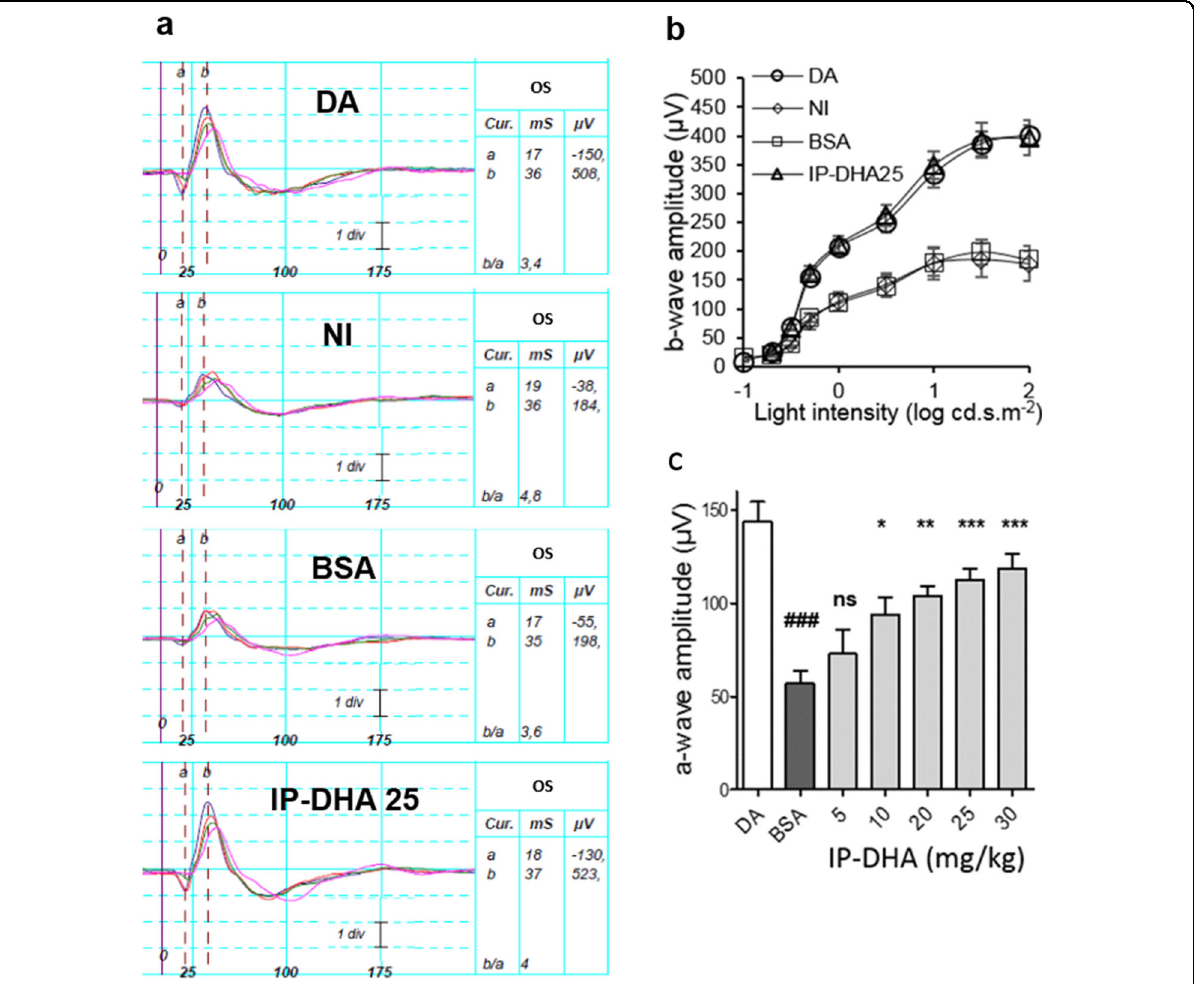
Fig. 4 Full- fi eld ERG recordings after light-induced acute retinal degeneration. a Full- fi eld ERG responses of IP-DHA (25 mg/kg)-treated or BSA- treated Abca4 − / − mice following light exposure were recorded under scotopic conditions and compared to nonexposed (DA) and noninjected (NI) light-exposed littermates. Data are representative ERG responses from left eyes (OS) to a light intensity of 0 to 2-log cd.s.m − 2 . Amplitude scale, 1 div = 156 µV. b ERG b-wave amplitudes plotted as a function of light intensity were fully preserved in IP-DHA 25-treated Abca4 − / − mice compared to BSA-treated animals. Error bars indicate the SEM of the means ( n ≥ 5). c The dose-dependent protection of ERG a-wave amplitudes by IP-DHA at 2-log cd.s.m − 2 . Error bars indicate the SEM ( n ≥ 5). One-way ANOVA with Bonferroni ’ s multiple comparison posttest: ### p < 0.001 BSA vs. DA mice; * p < 0.05, ** p < 0.01, *** p < 0.001 IP-DHA versus BSA-treated mice; BSA vs. IP-DHA 5 nonsigni fi cant,